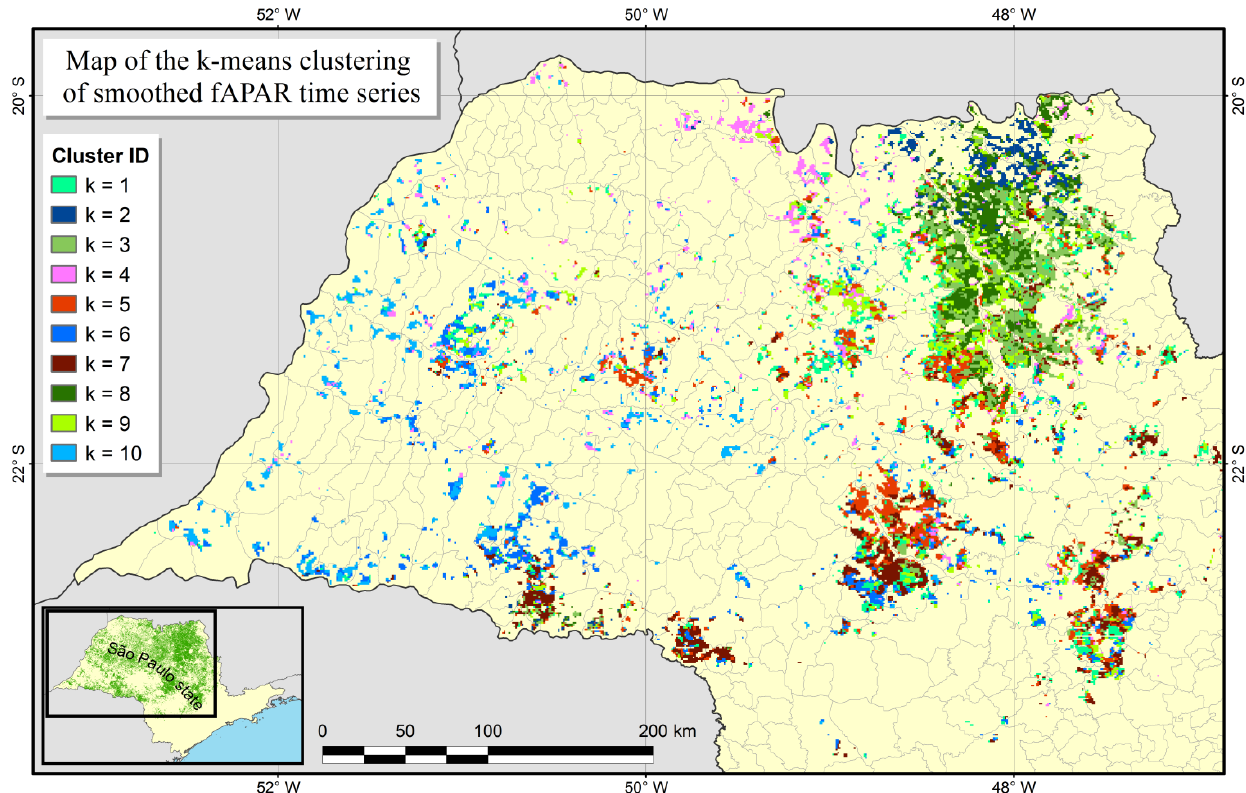
Figure 8. Map of 10 k- means clusters of smoothed fAPAR time series with π ≥ 75% over the state of São